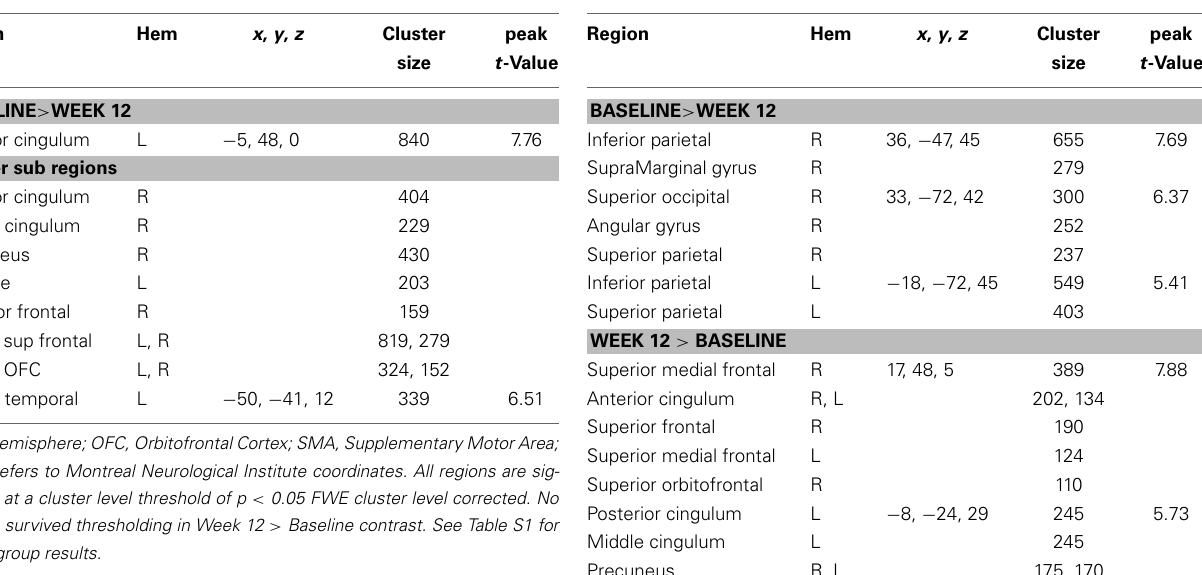
Table 4 | Changes in dACC functional connectivity for the contrast incongruent greater than congruent following smoking cessation therapy with